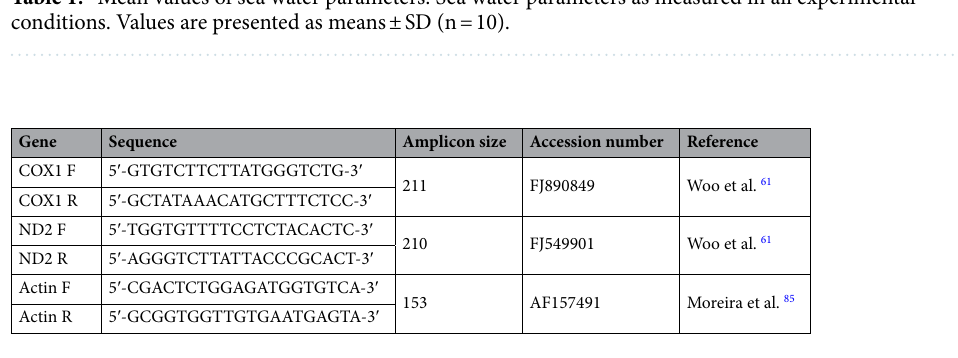
Table 2. Primers used for the estimation of gene expression